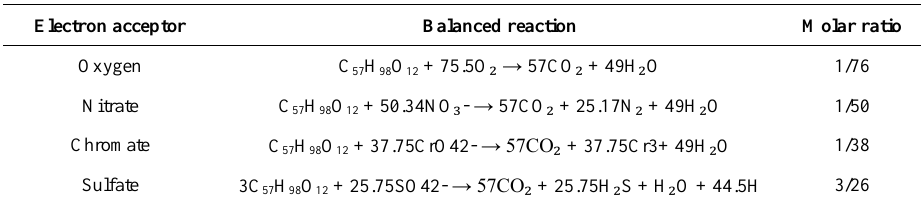
Table 2. Calculated molar ratios of stoichiometric electron donor demand for redox reactions of anaerobic